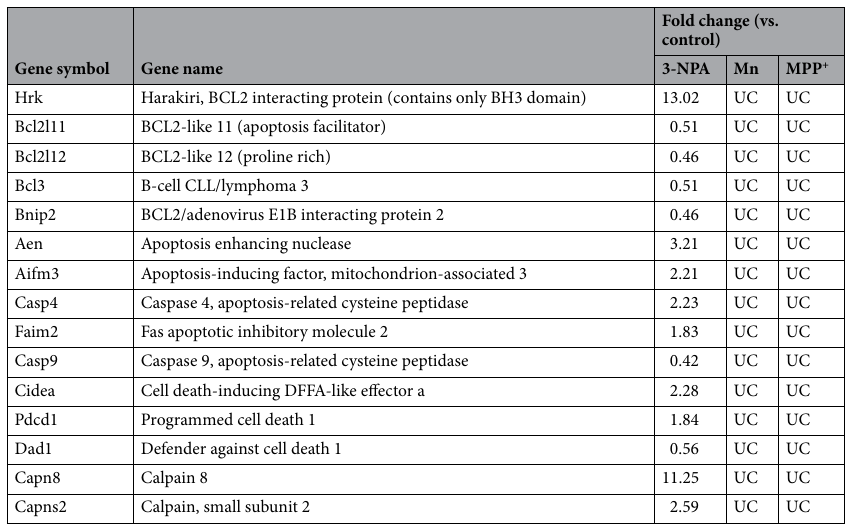
Table 2. List of autophagic and apoptotic genes differentially regulated across Mn/MPP + /3-NPA treatment. The gene symbol and gene name of different Autophagy and Apoptotic markers along with the fold change in expression (vs. control) noted in the transcriptomics experiment are provided. UC =